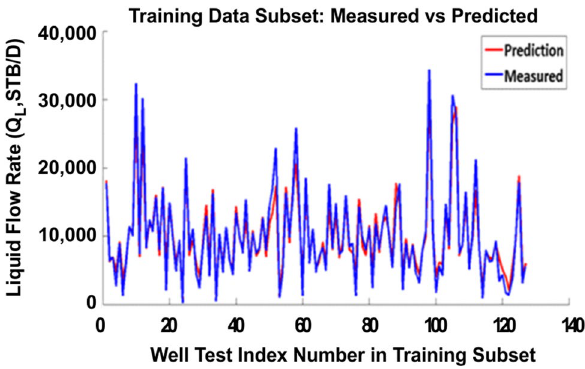
Fig. 4 Liquid flow-rate ( Q L ) prediction reliability and accuracy for the Reshadat oil field training data subset applying the GA optimized Eq. (8)